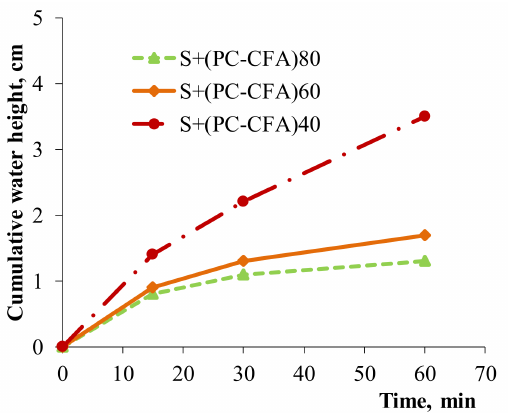
Figure 5. Cumulative height of water absorbed by capillarity of the solidified